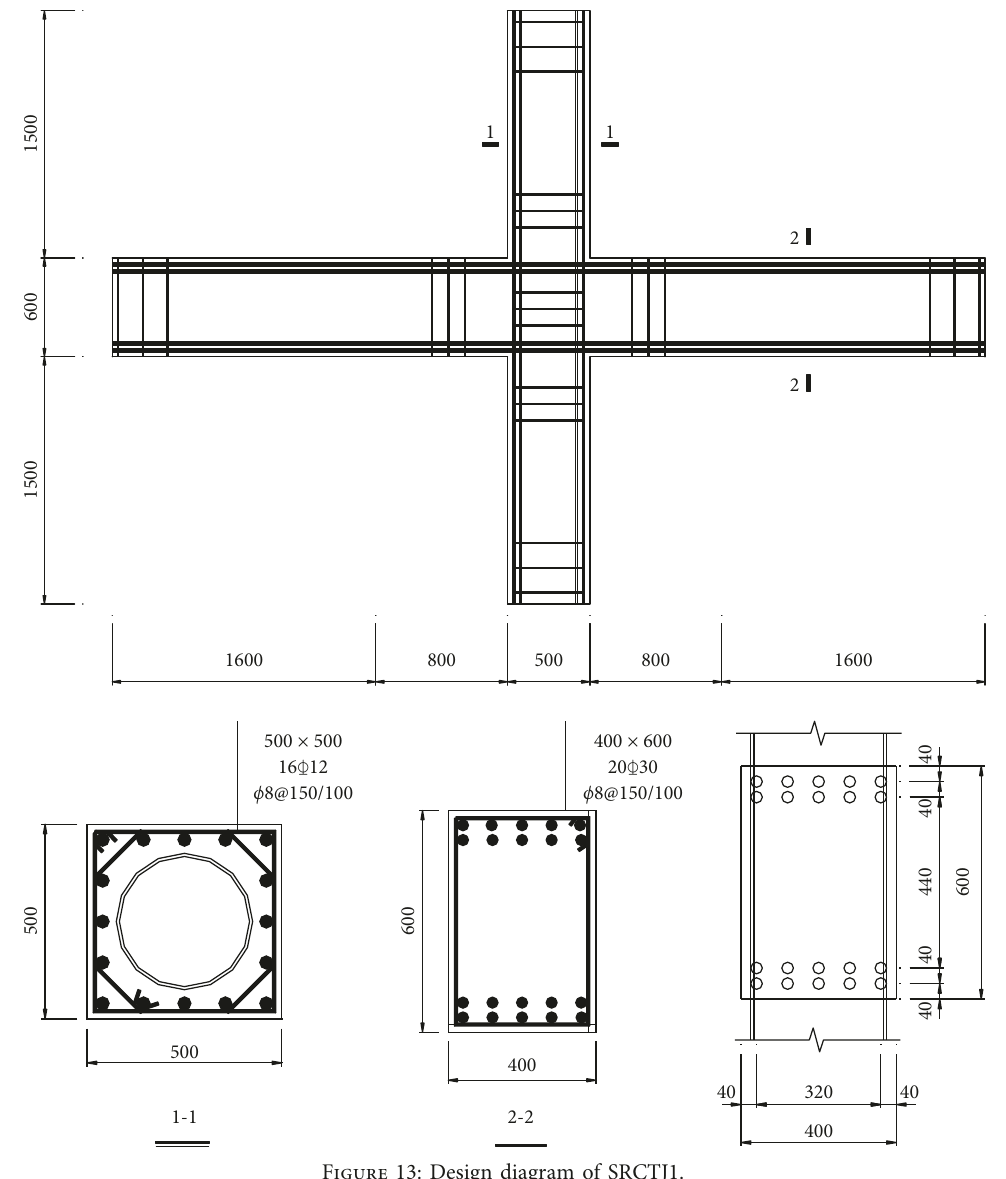
Figure 13: Design diagram of SRCTJ1.